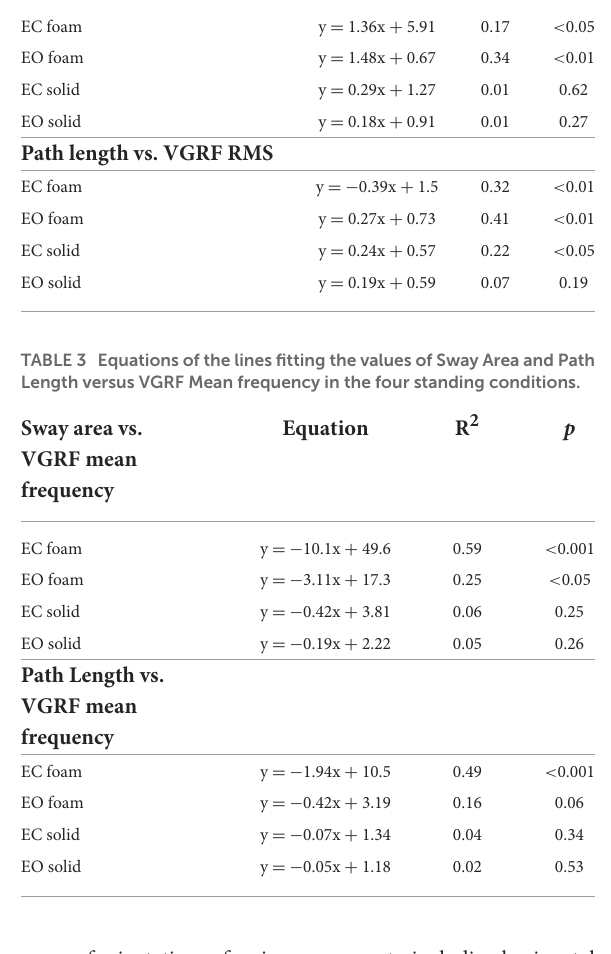
TABLE 2 Equations of the lines fitting the values of Sway Area and Path Length versus VGRF RMS in the four standing conditions. Sway area vs. VGRF RMS